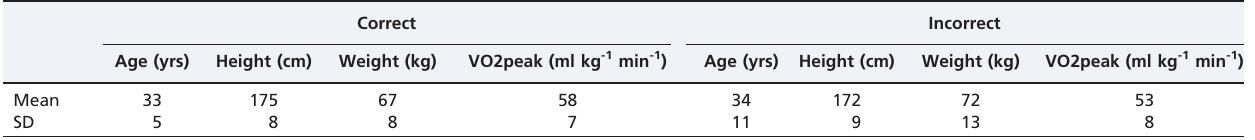
Table 1 - Participant characteristics for correct knowledge (female N = 3, male N = 2) and incorrect knowledge groups (female N = 3, male N =